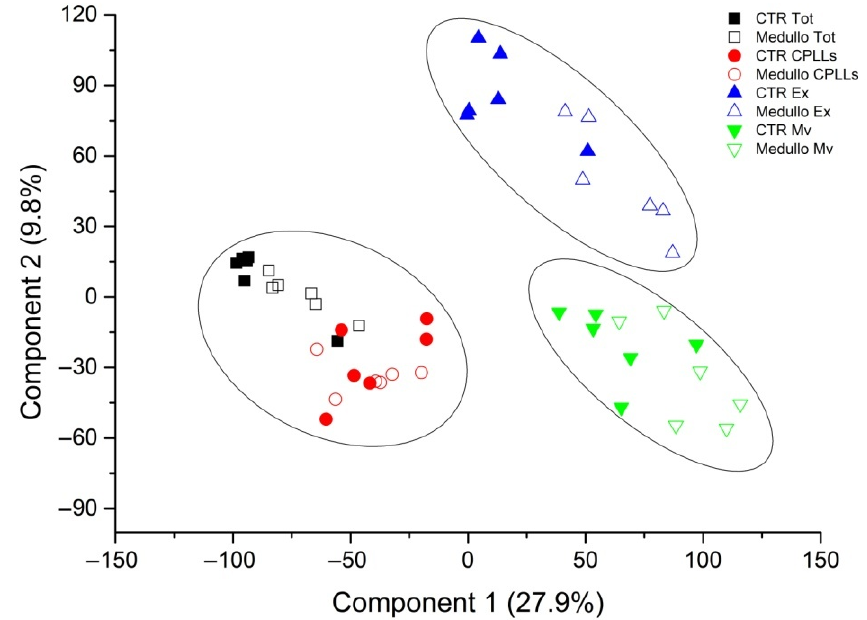
Figure 2. Multidimensional scaling (MDS) analysis of the proteins identified in CSF from EVD in MB or control samples. The two-dimensional scatter plot of MDS analysis shows the unsupervised cluster analysis of all CSF proteins identified from the EVD of MB (open symbol) and controls (solid symbol) in total (black square), CPLL (red circle), Mv (green triangle), and Ex (blue triangle) fractions. Ellipses show the 95% CI of the two clusters. MDS analysis identified three clusters corresponding to soluble proteins (total and CPLL fraction) and the extracellular vesicle fractions distinct in Mv and Ex fractions. No outliers were detected.